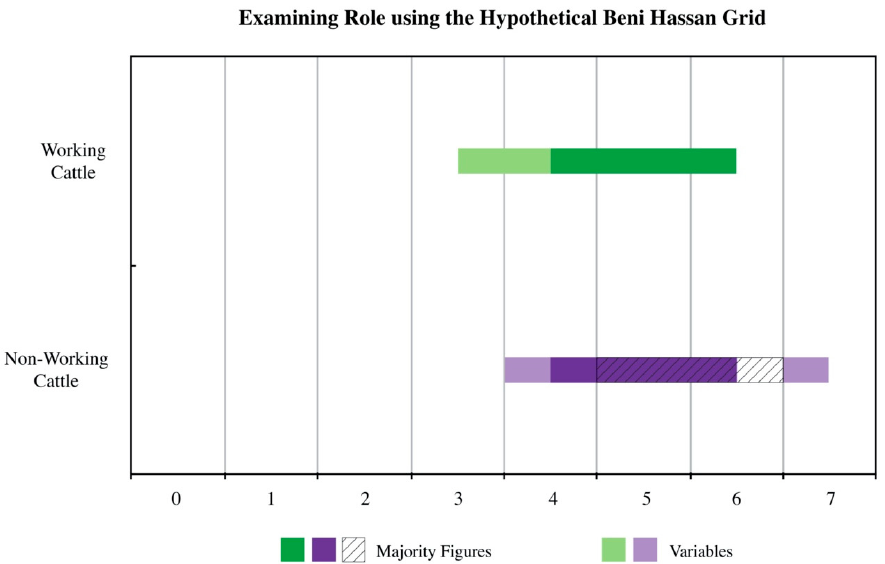
Figure 12. Examining the role of cattle using the hypothetical Beni Hassan grid.